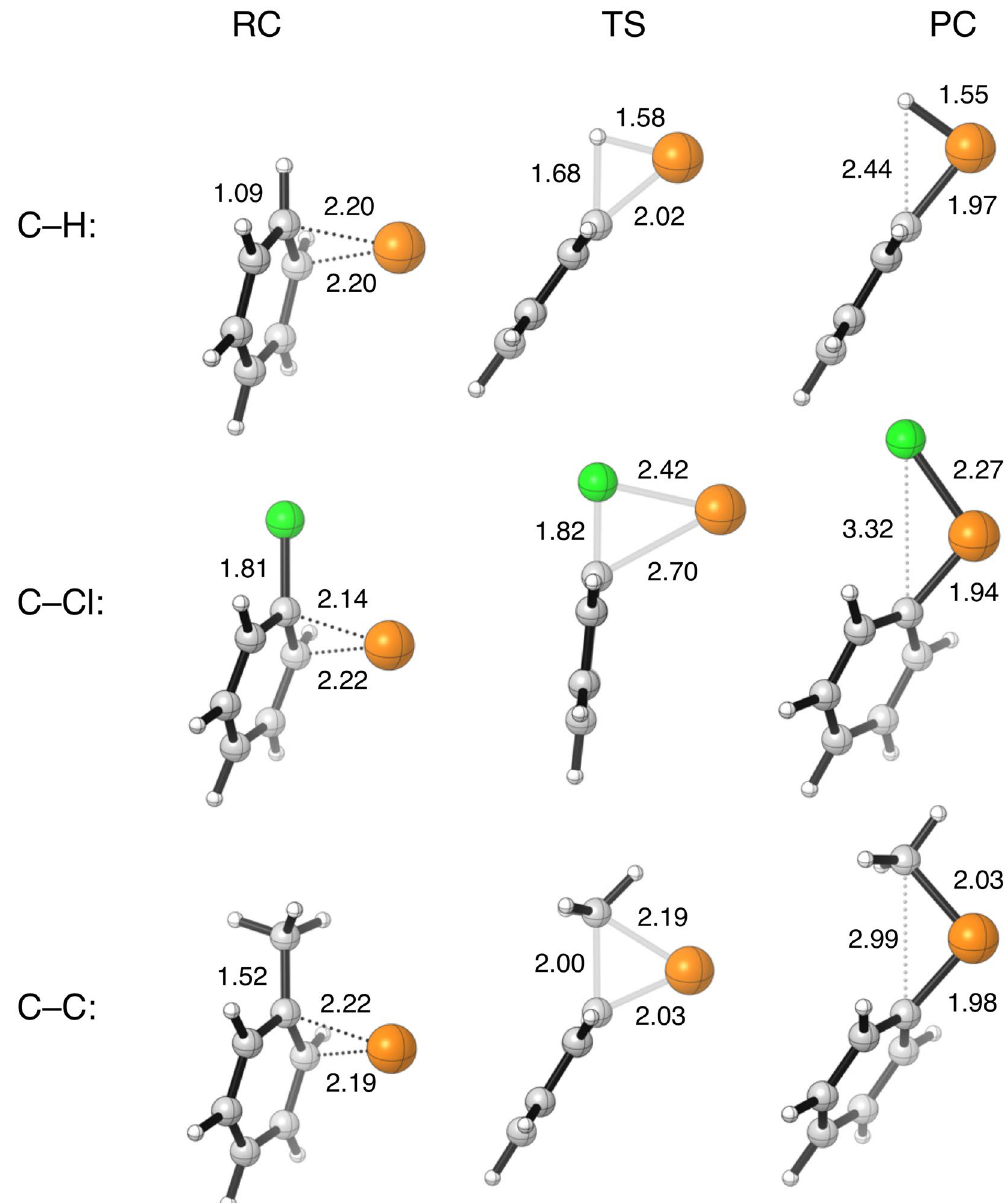
Figure 3. Representative geometries of the stationary points (in Å) for the oxidative insertion of Pd into the benzene C–H, chlorobenzene C–Cl, and toluene C–C bond, computed at